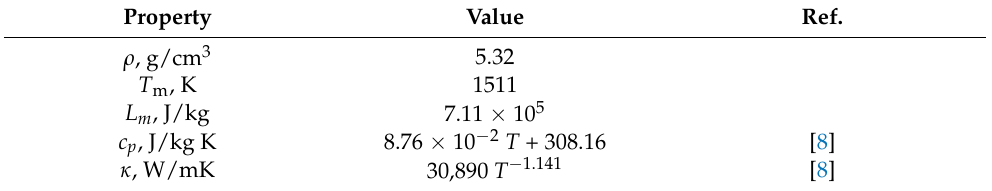
Table A9. c -GaAs—thermophysical